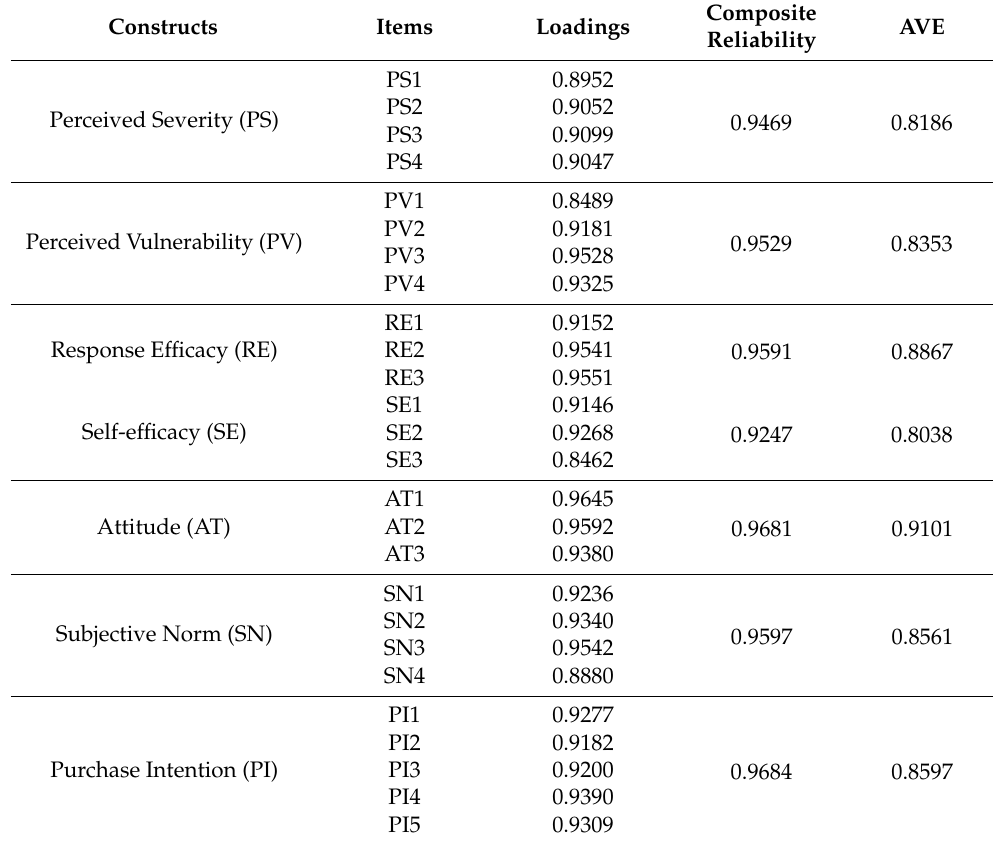
Table 4. Indicator Loadings, Composite Reliability and